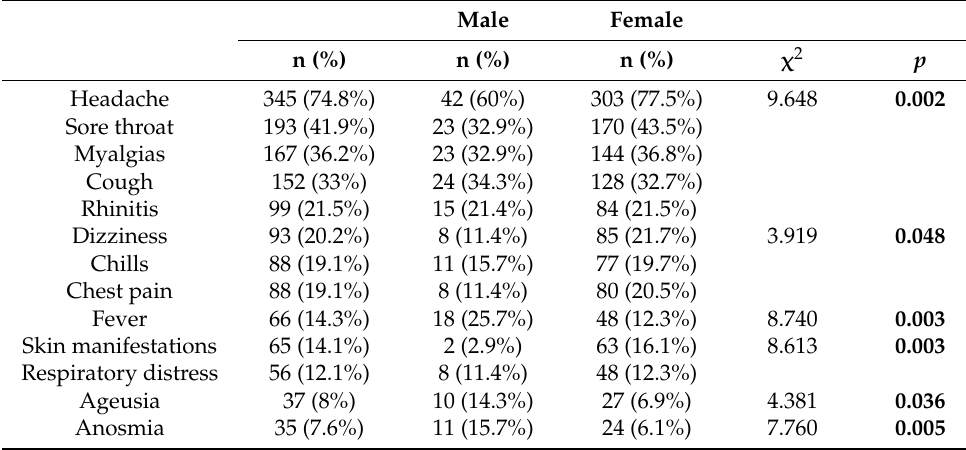
Table 4. COVID-19-related symptomatology present in the